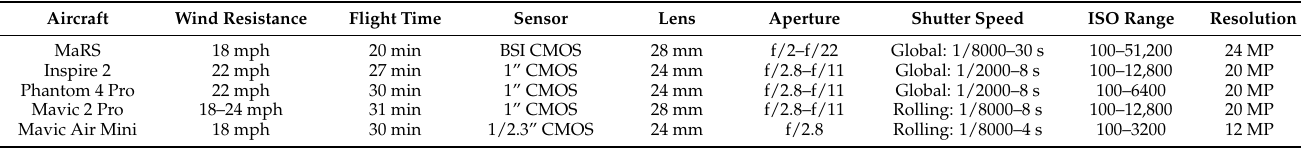
Table 2. Specifications of the five small unmanned aerial systems (sUAS) and their respective sensor used in this study. Aircraft Wind